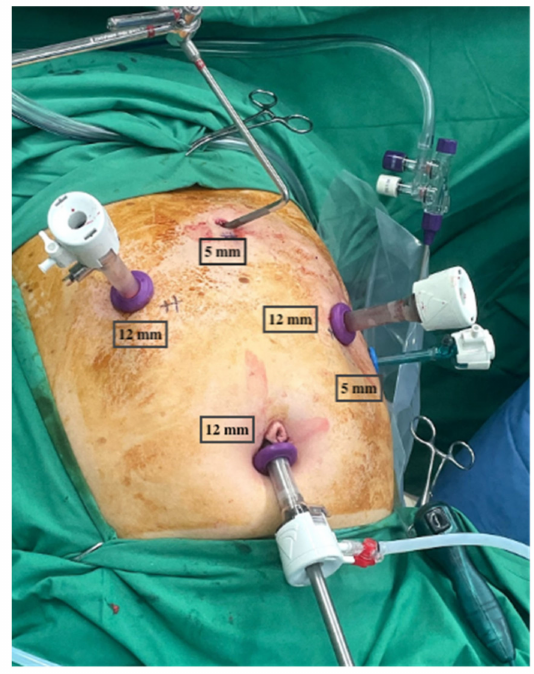
Figure 1. Routine trocar placement. Routine mobilization of the stomach via division of the greater omentum from trans- verse colon and gastrosplenic ligament was performed with the use of an energy device (Voyant Meryland Fusion, Applied Medical, Rancho Santa Margarita, CA, USA). The lesser omentum was then dissected, starting from the duodenal bulb, following the hepatoduo- denal ligament and then close to the liver edge cephalad towards the phreno-esophageal membrane, finishing on the right diaphragmatic crus. D2 lymphadenectomy with dissec- tion of right gastric, left and right gastroepiploic, left gastric, celiac, splenic, and common hepatic nodes was performed as part of the standard procedure (Figure 2). The first part of the duodenum after full mobilization circumferentially was transected with endoscopic linear stapler with 60 mm purple cartridges (Panther, Medical Healthcare, Beijing,